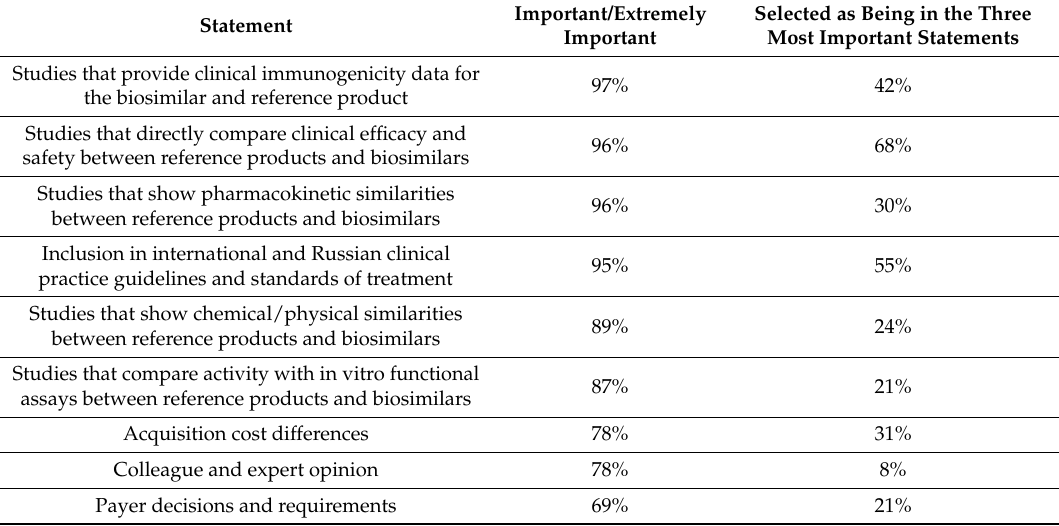
Table 2. The importance of types of information for making decisions to use biosimilar products ( n = 206).